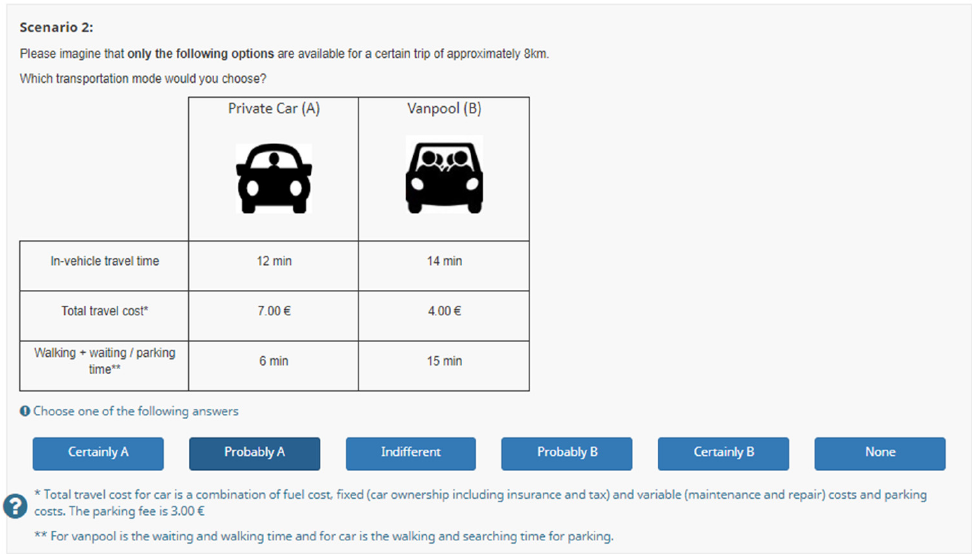
Figure 1. Stated preference experiment scenario for a car/vanpool scenario (example).